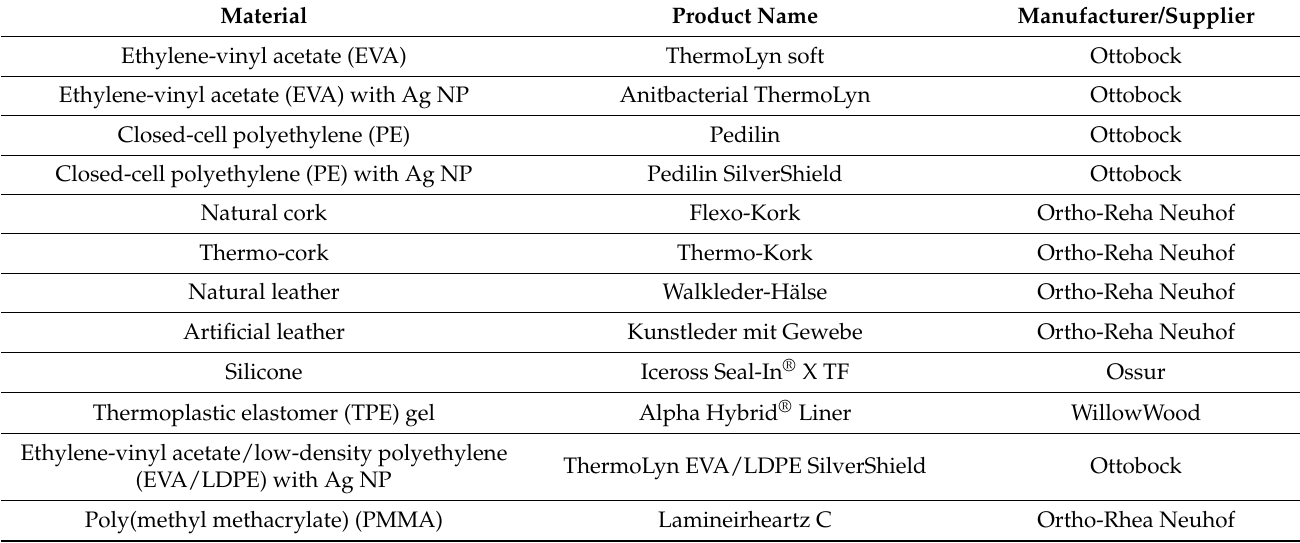
Table 1. List of materials